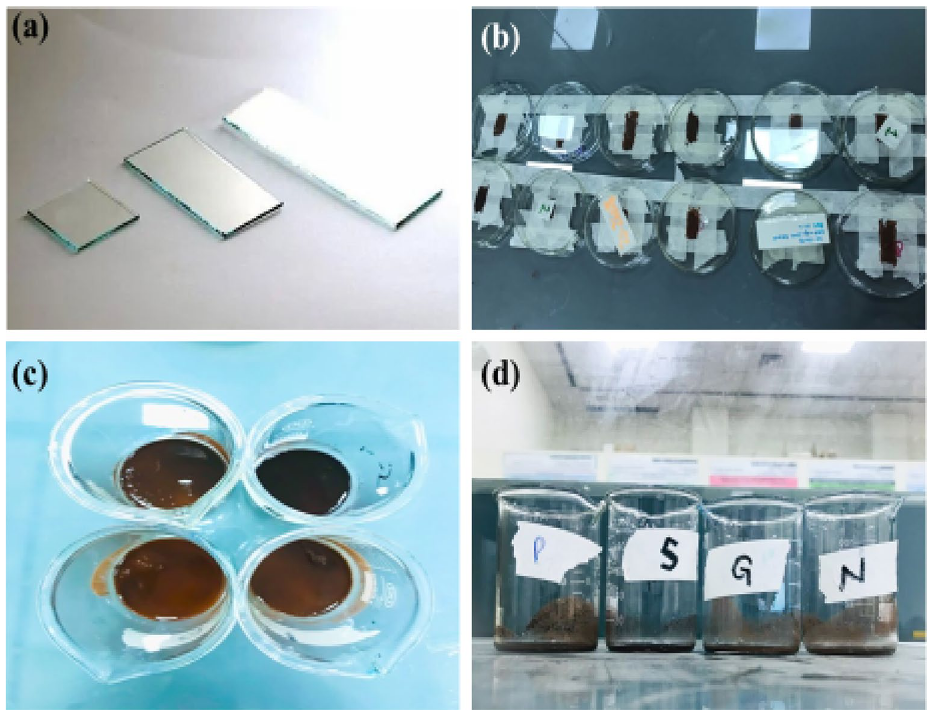
Figure 3. Preliminary setup for the preparation of photoanode: ( a ) FTO glass, ( b ) Doctor’s blade method, ( c ) Top view of the sonicated homogenized solution of bare/doped BiFeO 3 , and ( d ) Lateral view of sonicated homogenized solution of bare/doped BiFeO 3